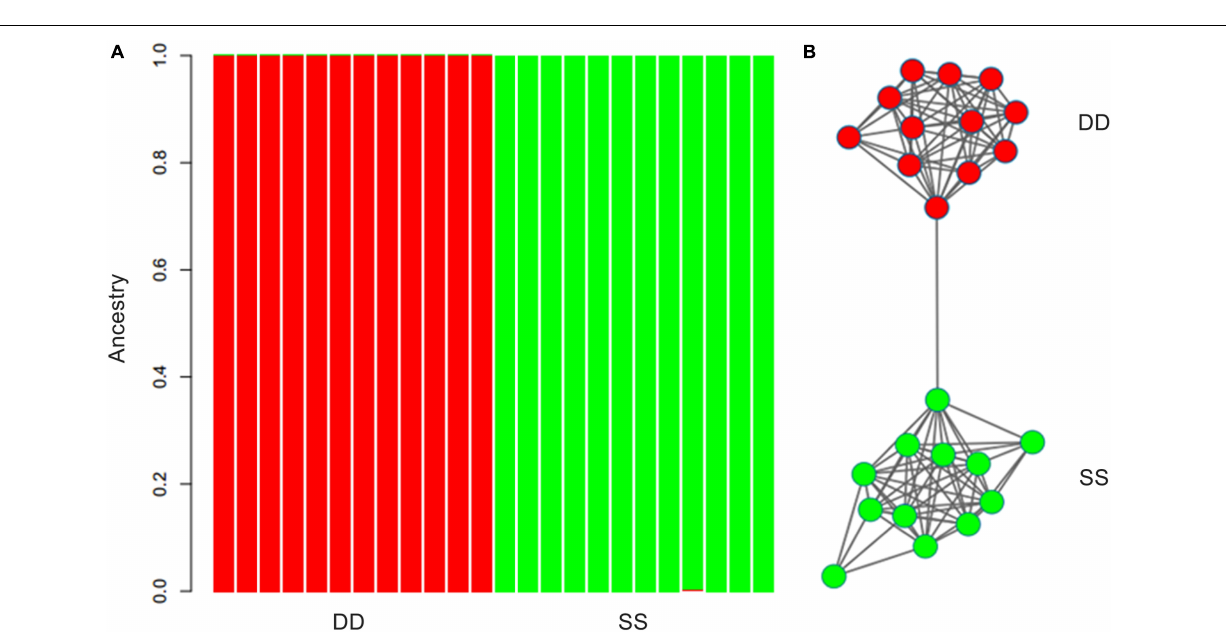
FIGURE 1 | Transitions and transversions occurring within a set of 73,557 single-nucleotide polymorphisms (SNPs).